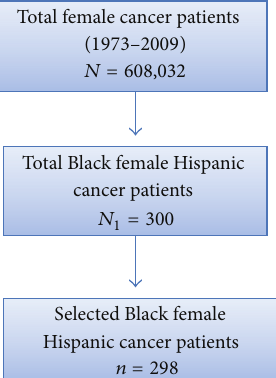
Figure 1: Selection of stratified random sample of Black Hispanic breast cancer patients from SEER (1973–2009) dataset represented as a pedigree chart.